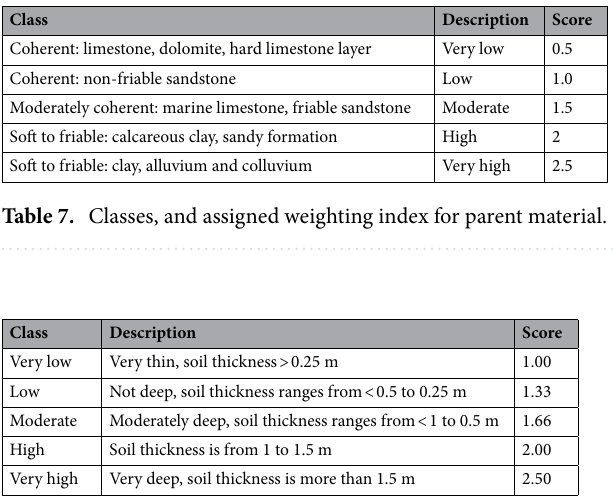
Table 8. Classes and assigned weighting index for soil physical–chemical properties.